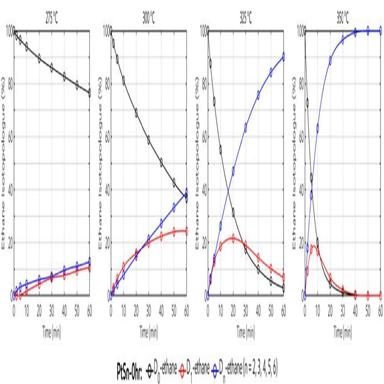
Monitoring H/D exchange between ethane and D2 on PtSn-0hr at selected temperatures. C2H6 (black), C2H5D (red), sum of C2H4D2, C2H3D3, C2H2D4, C2HD5 and C2D6 (blue). (For interpretation of the references to colour in this figure legend, the reader is referred to the web version of this article.)